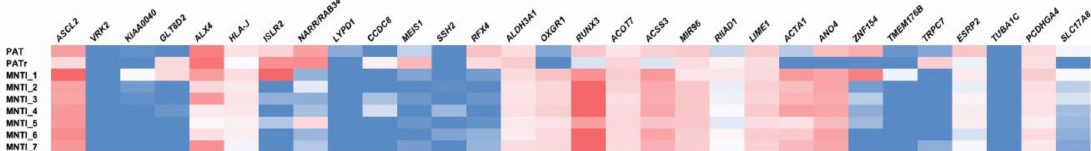
Figure 8. Heatmap depicting the top 30 differentially regulated genes among MNTI/PAT samples vs. MBG3. Color scale: Hypermethylated genes are reported in red, while hypomethylated genes are in